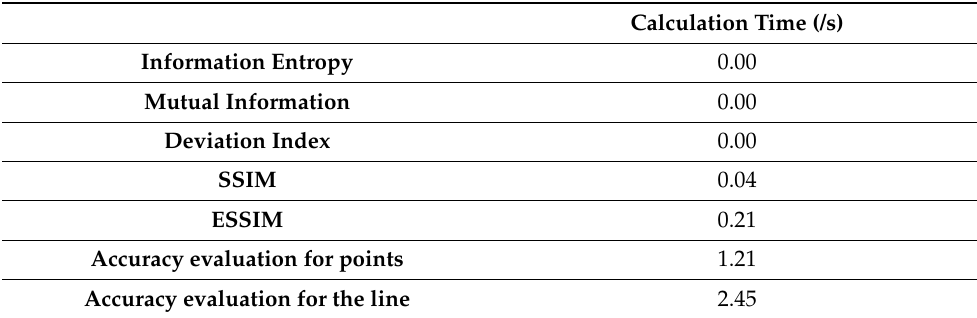
Table 9. Accuracy evaluation for the evaluation index